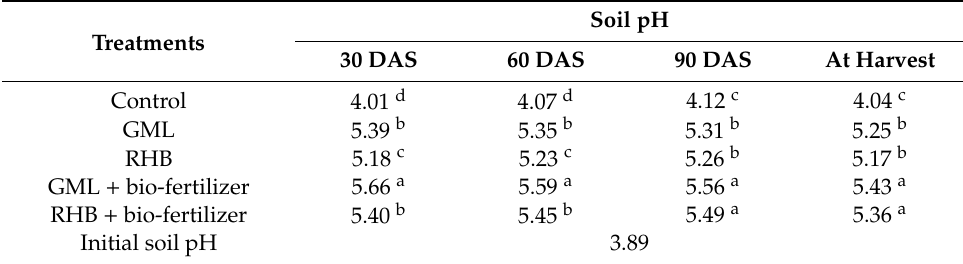
Table 4. E ff ects of applying amendments on pH of the acid sulfate soil. Treatments